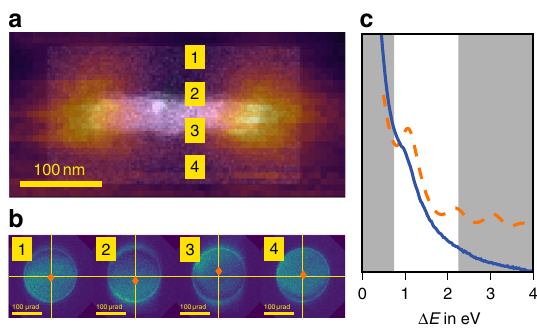
Fig. 2 EELS and IMT measurements. a HAADF image (black and white) and overall loss probability (color overlay), b subset of inelastic EFDPs with indicated centers-of-mass, and c experimental (solid line) and simulated (dashed line) overall EEL spectra with employed energy slit indicated. The beam positions are indicated with respect to the Al rod. Note that an effective dielectric screening (see Methods), accounting for the aluminum oxide surface and the substrate, was necessary to shift the simulated peak to the experimentally observed value. The strong increase of the EEL spectra towards smaller losses are due to the monopole surface mode centered at approximately 0.7